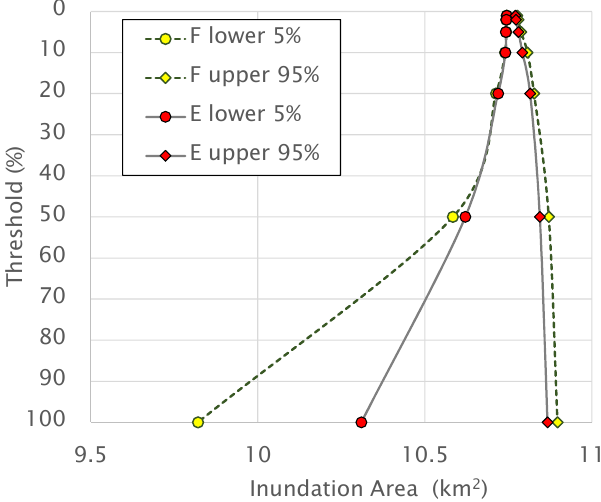
Figure 8. Uncertainty bounds according to the thresholds based on the F and E likelihood measures.